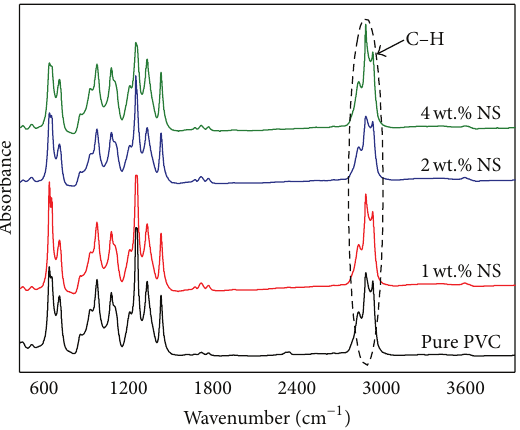
Figure 3: FTIR spectra for the PVC-SiO 2 nanocomposite